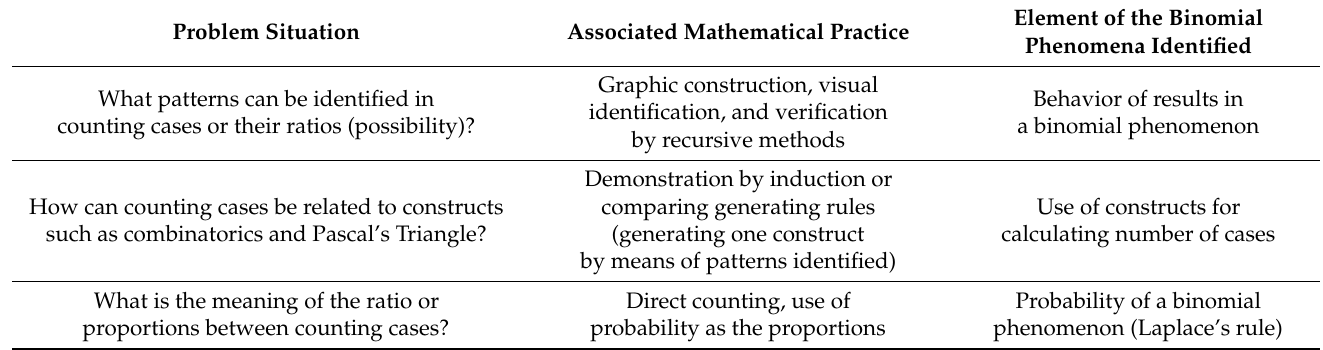
Table 4. How problem situations from historical problem situations (15th century–16th century) could be proposed in the current